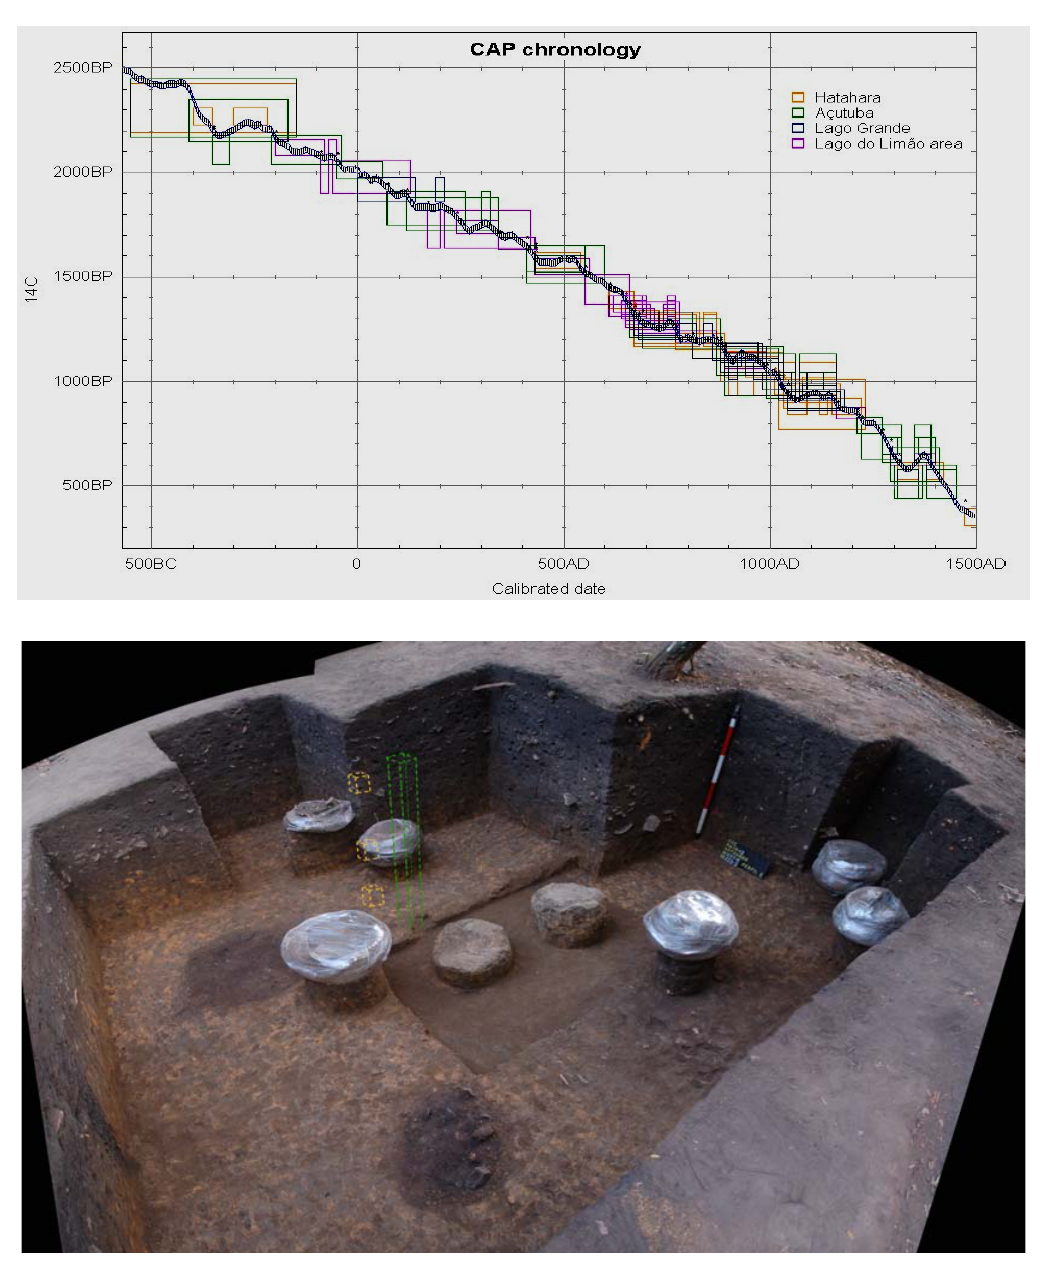
Figure 2. Top: Chronological synthesis of ceramic occupations of sites studied by the Central Amazon Project (current to 2006). Rectangles are calibrated age ranges (IntCal04.14c). Bottom: Excavations at the Hatahara site. Ceramic vessels left in situ are different-period funerary urns. Note features filled with darker sediments originating higher in the deposit. Dotted lines show sampling for geoarchaeological